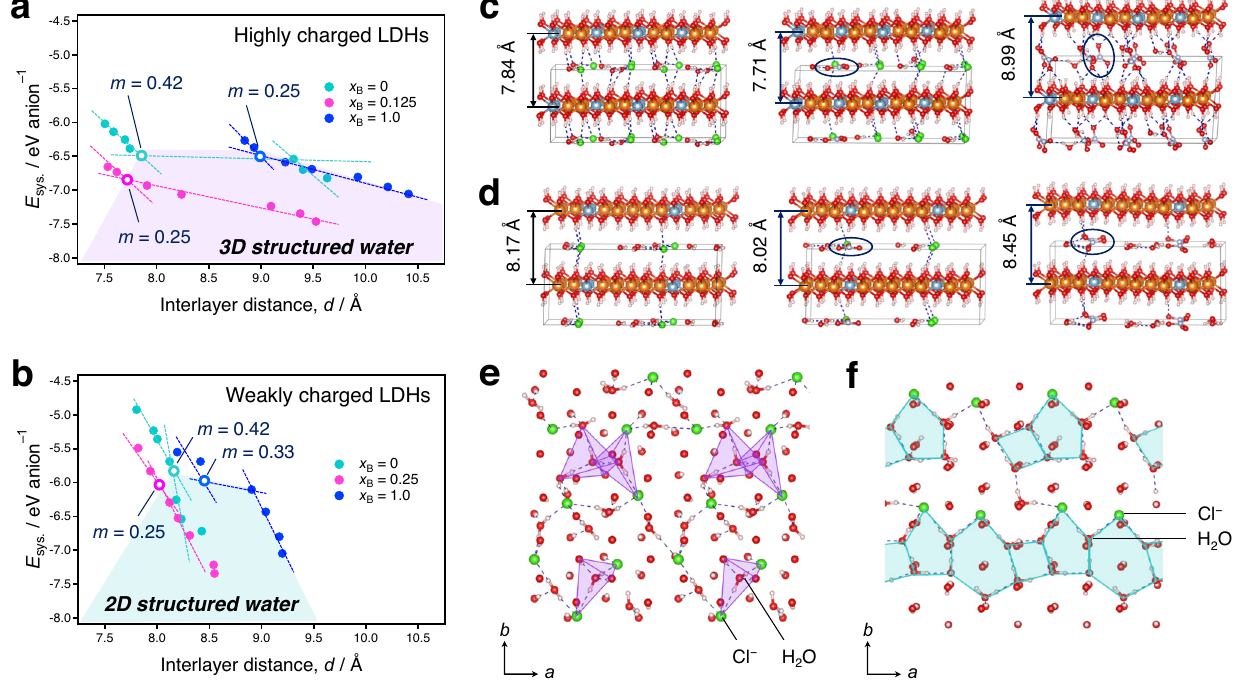
Fig. 5 | The energy diagram of the nitrate ion storage and the hydrogen-bond structure in the interlayer space. The calculated binding energy of the ion- exchange system as a function of the interlayer distance of the optimised LDH structure a with highly charged LDHs [Mg 0.66 Al 0.33 (OH) 2 ](NO 3 − ) x B (Cl − ) 1 − x B · m H 2 O and b with weakly charged LDHs: [Mg 0.833 Al 0.166 (OH) 2 ] (NO 3 − ) x B (Cl − ) 1 − x B · m H 2 O. The optimised LDH structures c of highly charged LDHs with x B = 0.0 ( m =0.42), x B = 0.125 ( m = 0.25), and x B = 1.0 ( m = 0.25), and d of weakly charged LDHs with x B = 0.0 ( m = 0.42), x B = 0.25 ( m =0.25), and x B =1.0 ( m = 0.33). The three-dimensional and two-dimensional structured